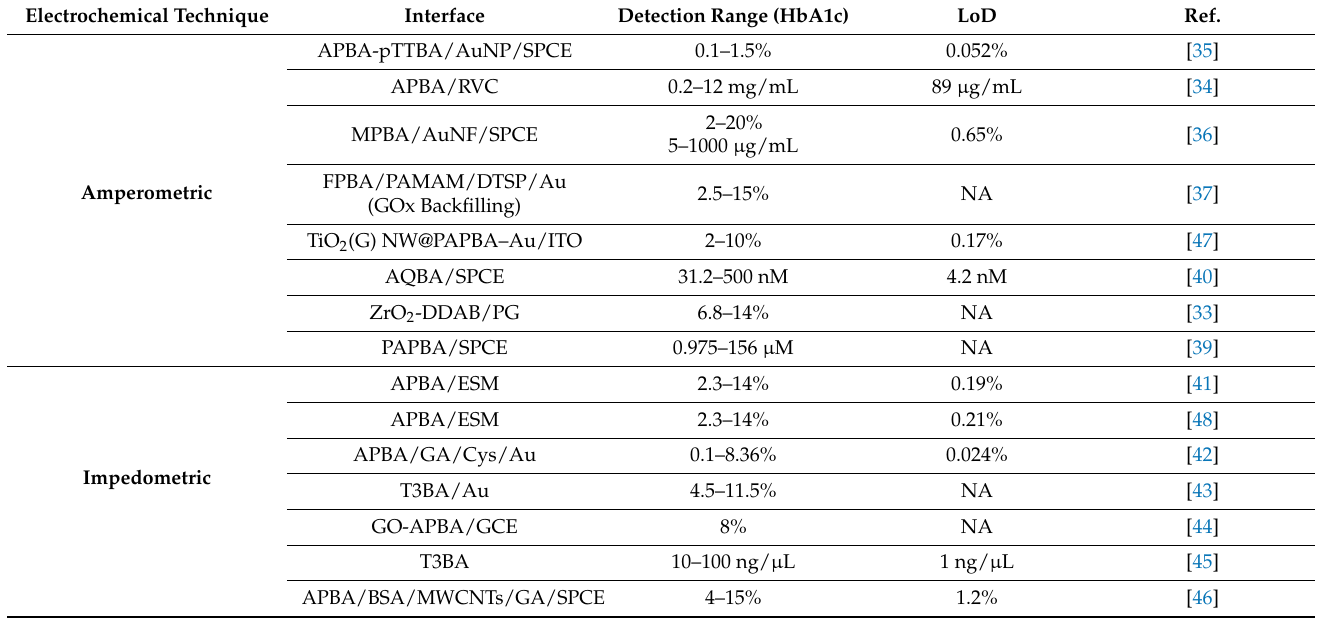
Table 1. Boronic acid-based electrochemical sensors for direct detection of HbA1c. Electrochemical